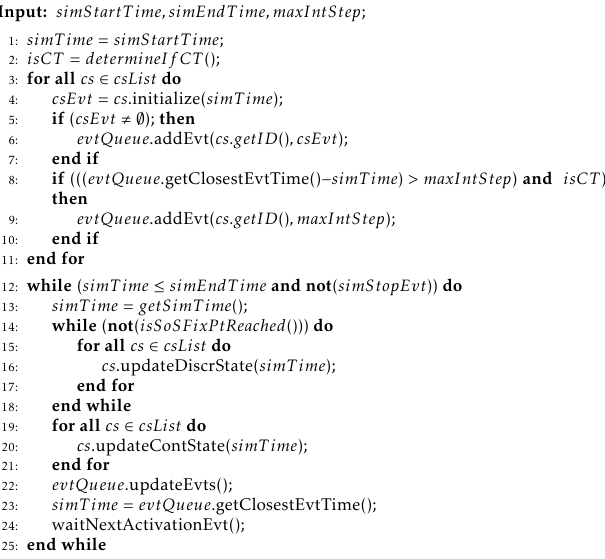
Algorithm 1 DESYRE FMI MA for